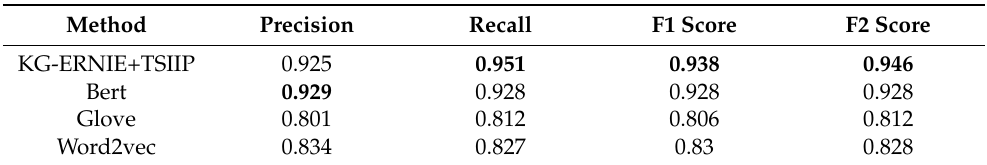
Table 4. Comparison of experimental results of different word embedding models. The bold numbers are the best